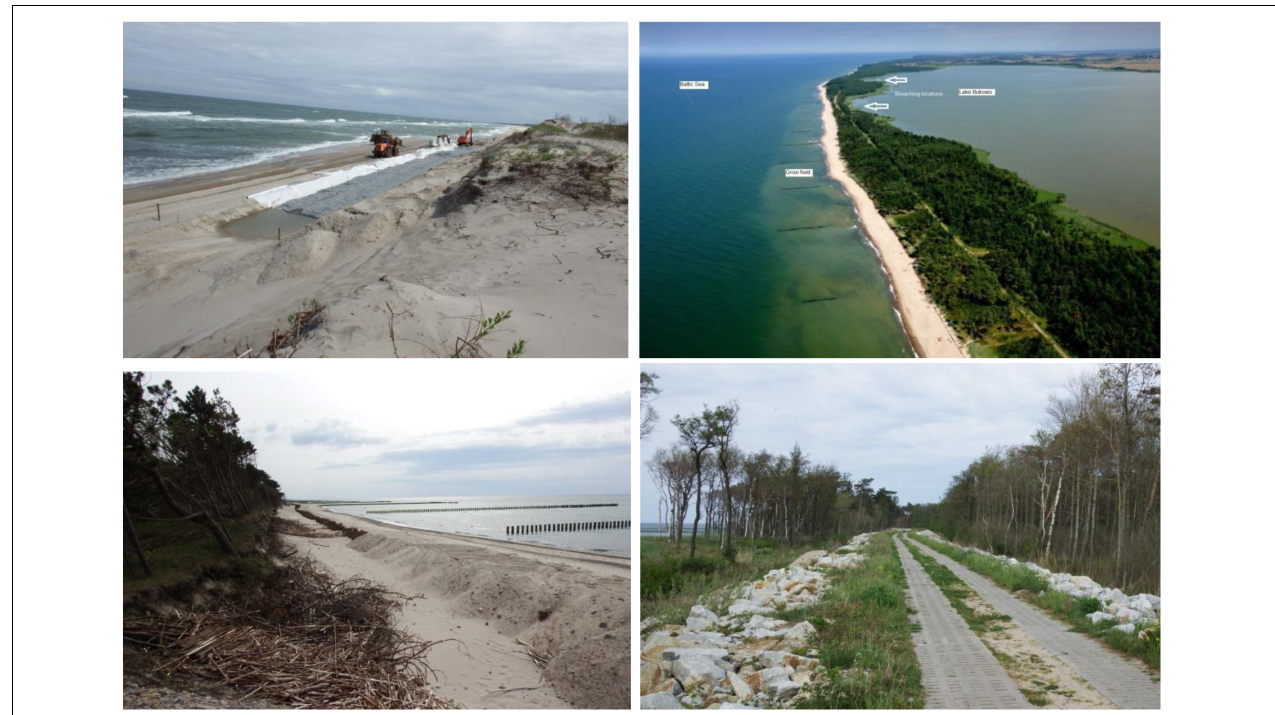
FIGURE 2 | Jamno barrier near outlet from lake in 2015,photo. G. Ró˙zy´nski - top left; Bukowo barrier, adapted from www.darlowo.naszemiasto.pl - top right; Kopa´n barrier in 2015, photo. G. Ró˙zy´nski - bottom left; storm barrage on lake Kopa´n barrier in 2015, photo. G. Ró˙zy´nski - bottom